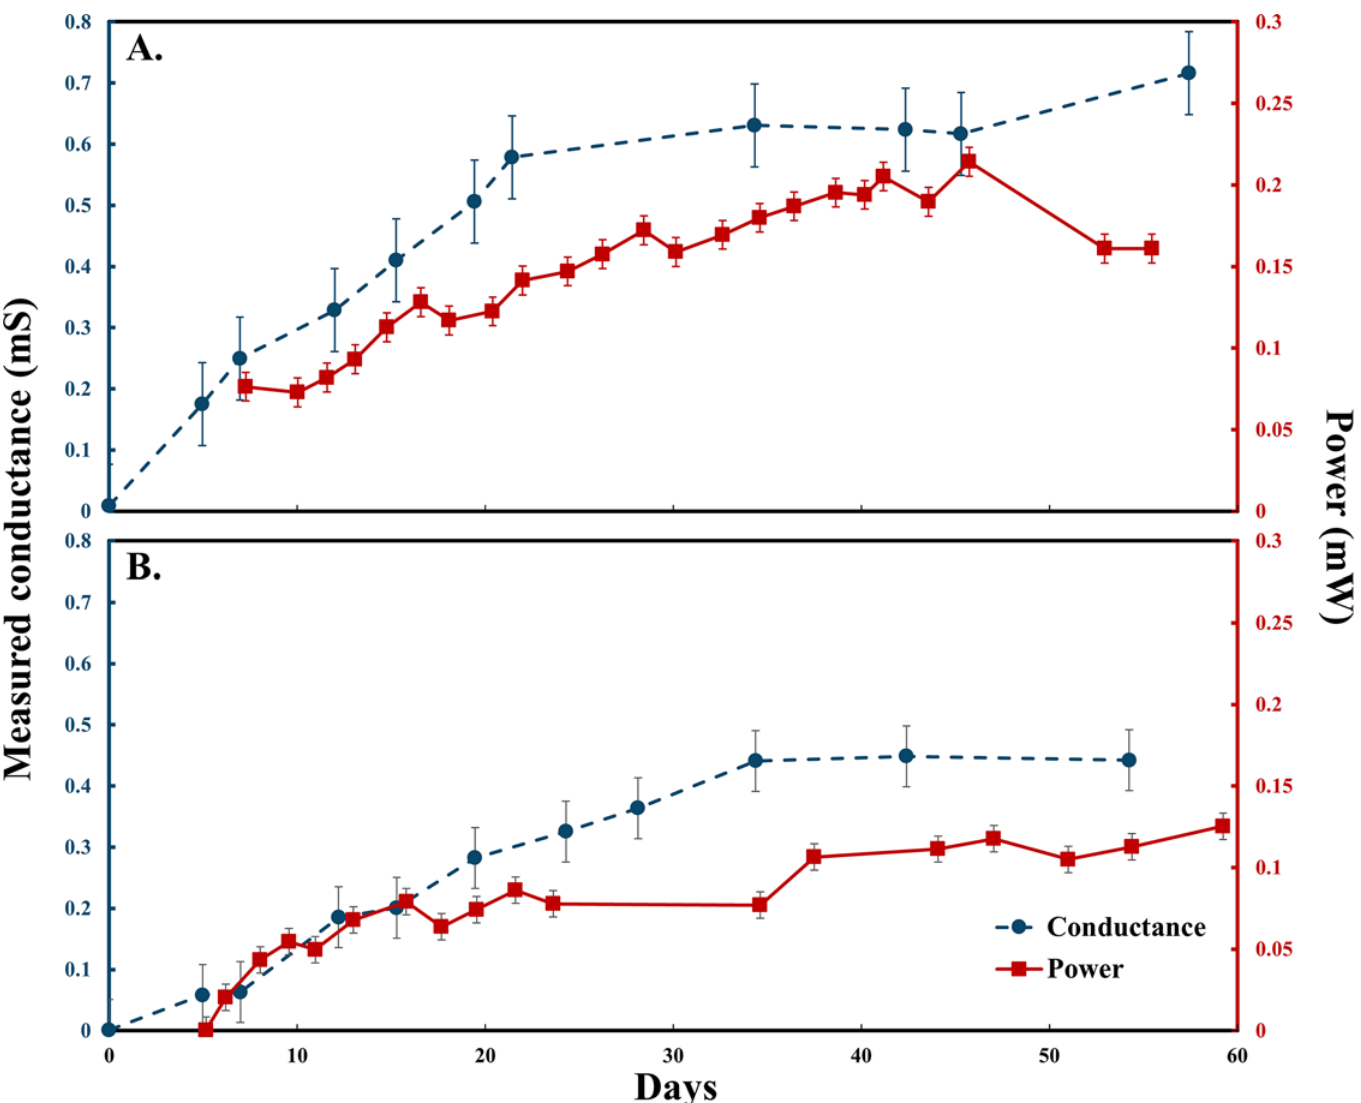
Fig 3. Measured conductance and power of DA-MFCs and SA-MFCs over time. (A) DA-MFC with 50 μ m non-conductive gap, (B) SA-MFC with 50 μ m non-conductive gap. Error bars represent standard deviation (n =